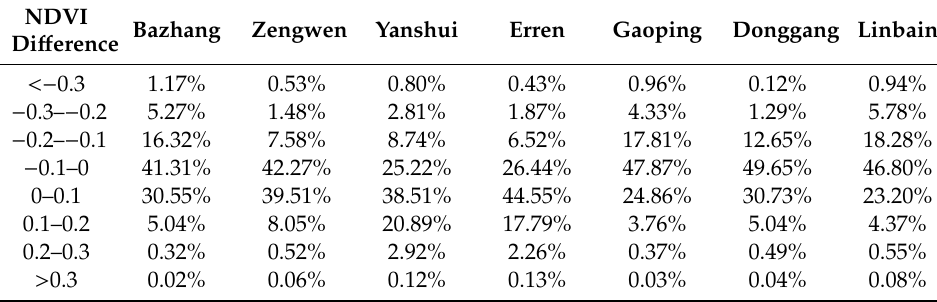
Table 7. NDVI di ff erence of seven river basins from pre- to